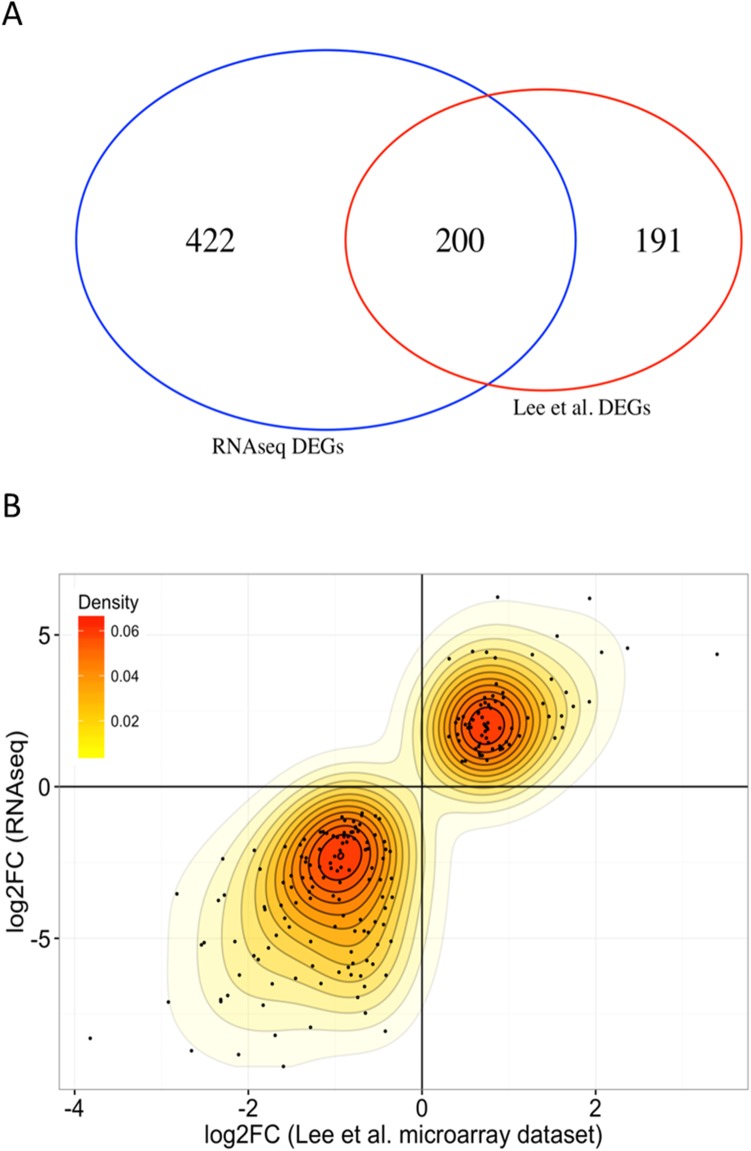
Comparison of differentially expressed genes in our RNA-seq and public dataset.(A) Overlap between differentially expressed genes identified from microarray data (Lee et al.) and RNA-seq for the HeH versus t(12;21) comparison. The intersection of 200 genes represents a 10-fold enrichment compared to the expected intersection (20) when DEGs are picked randomly. (B) Comparison of logFCs for DEGs identified in both the microarray and RNA-seq analysis. Pearson’s product-moment correlation between log2FCs = 0.844. Spearman’s rank correlation = 0.793. We note that expression changes are coherent (in the same direction) for all DEGs identified from both datasets